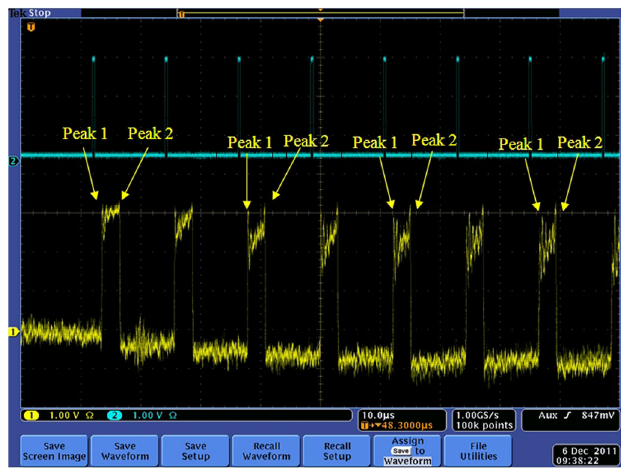
FIG. 20. Dependence of the He 1 þ beam current on V 1 and the corresponding fitting curve.